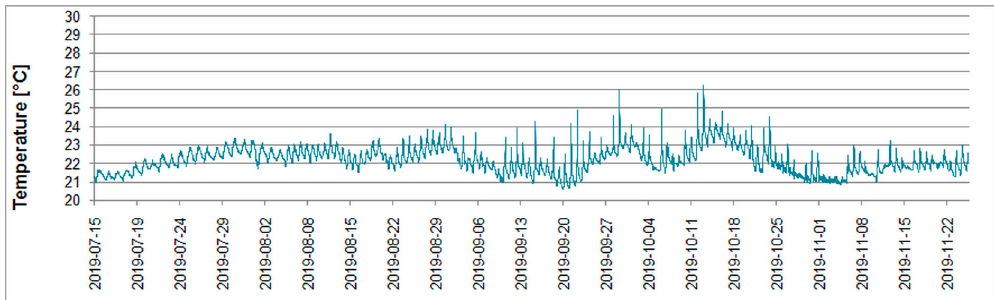
Figure 6. Floor temperature during the whole measurement period.